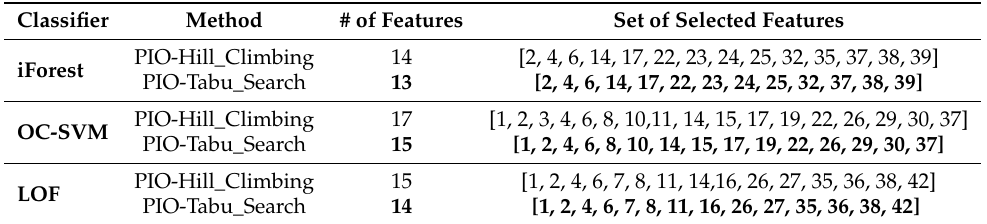
Table 6. The selected features from DNS records extracted from UNSW-NB15 by LS_PIO based on different classifiers and local search methods.